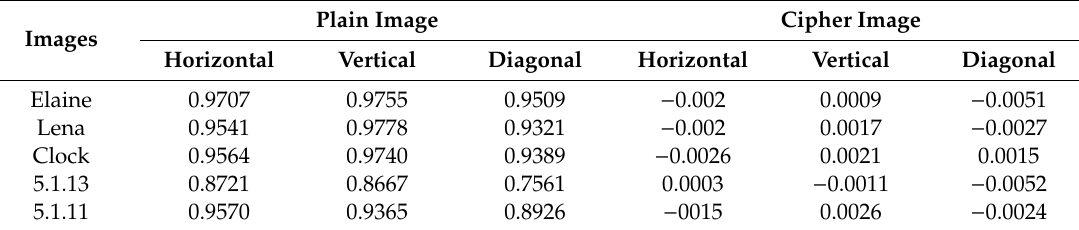
Figure 11. Elaine image pixel distribution in a different direction. ( a – c ) Original image pixel distribution in horizontal, vertical, and diagonal direction; ( d – f ) Cipher image pixel distribution in horizontal, vertical, and diagonal direction. Table 2. Pixel correlation coefficient values of sample images.